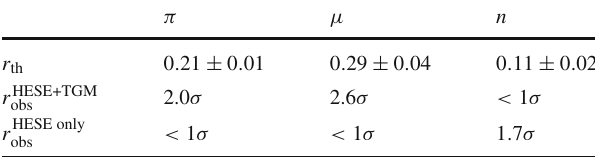
Table 2 Summary of the results. The expected track to shower ratio for each production mechanism is reported and compared with the astro- physical track to shower ratio obtained using HESE + throughgoing muons and HESE only. The tension between observations and expec- tations is quoted in terms of number of